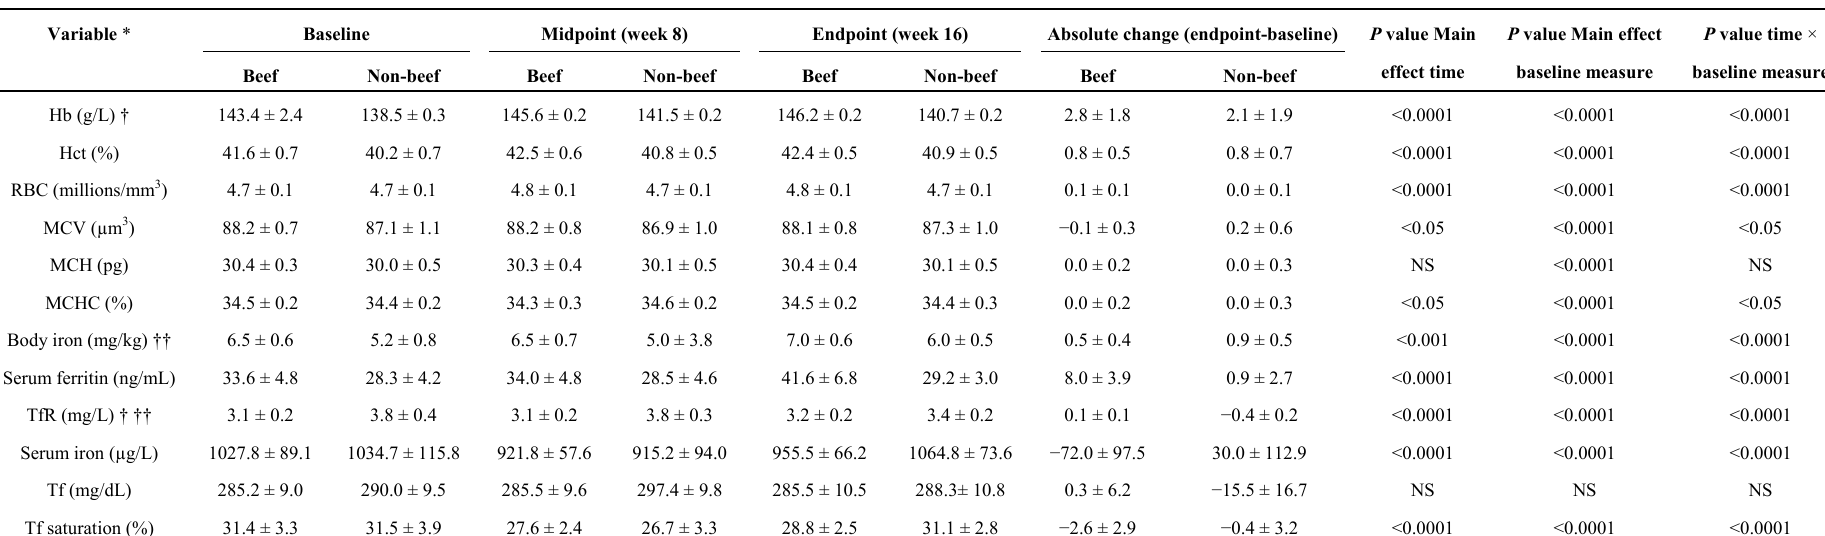
Table 3. Hematology and iron status measures ( n =